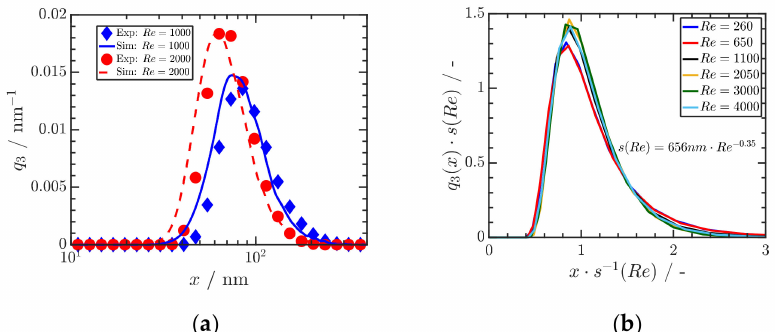
Figure 10. ( a ) Comparison of measured and calculated particle size distributions of Ibuprofen precipitated at three Reynolds numbers Re. An initial ibuprofen concentration of C ibu = 30 mg mL − 1 is used, and ibuprofen is dissolved in ethanol. ( b ) Self-similar size distributions depend on Reynolds number Re. Reprinted with permission from [50], Wiley,